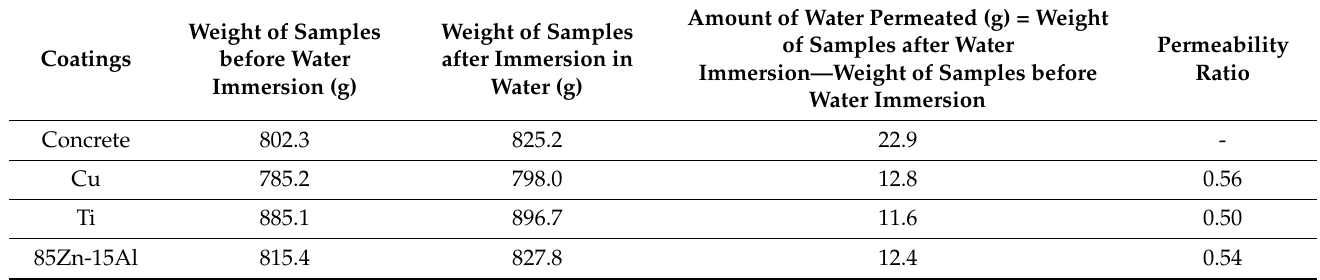
Table 4. Water permeability